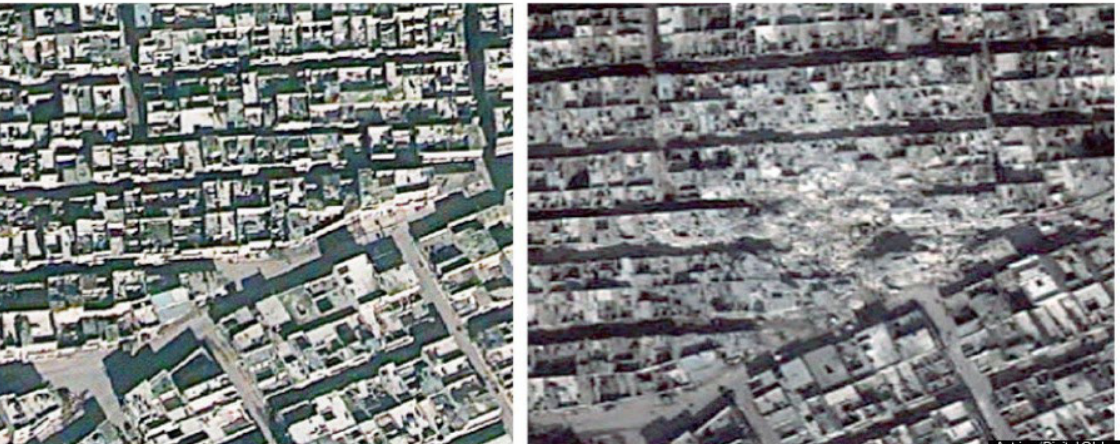
Figure 2: Effects of Aerial